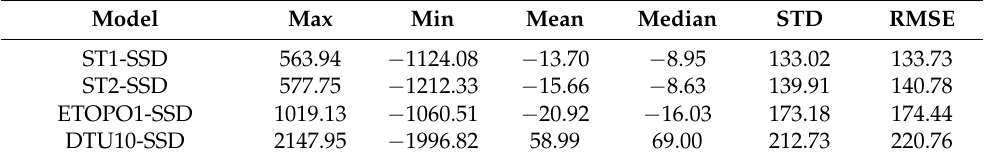
Figure 7. The model of the seafloor topography generated via ( a ) ST1, ( b ) ST, ( c ) ETOPO1, and ( d ) DTU10. The magenta boxes indicate the locations of the Xisha Islands, Zhongsha Islands, Zhongsha North Ridge, and Zhongnanhai Mountain. Table 2. Statistical results of the difference between the model values and check data. Unit: m.